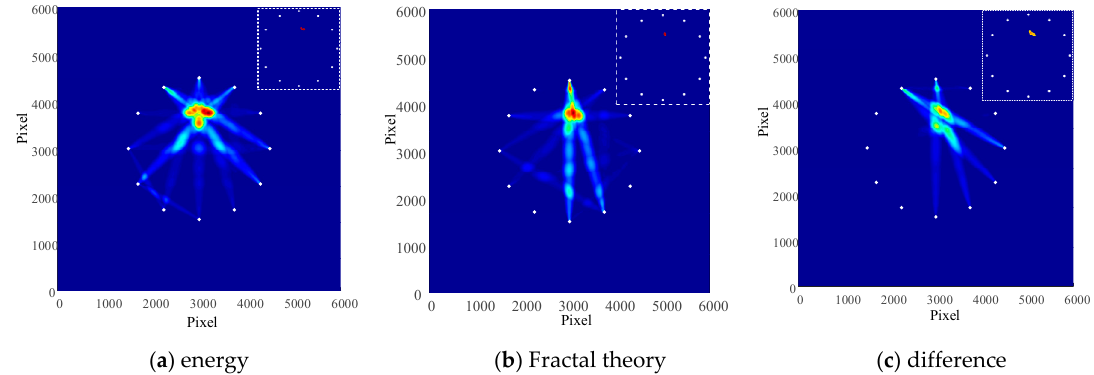
Figure 11. Damage imaging location results of different algorithms. ( a ) energy; ( b ) Fractal theory; ( c ) difference.